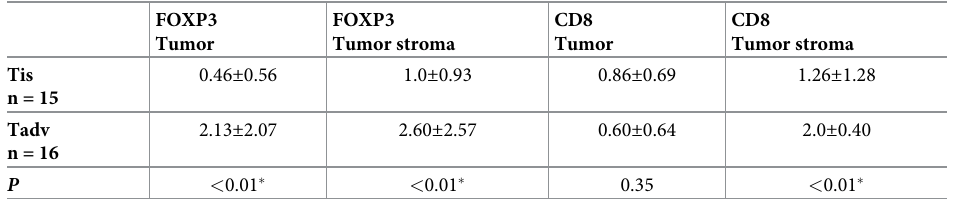
Tis, carcinoma in situ; Tadv, advanced carcinoma. � Un-paired t -test.